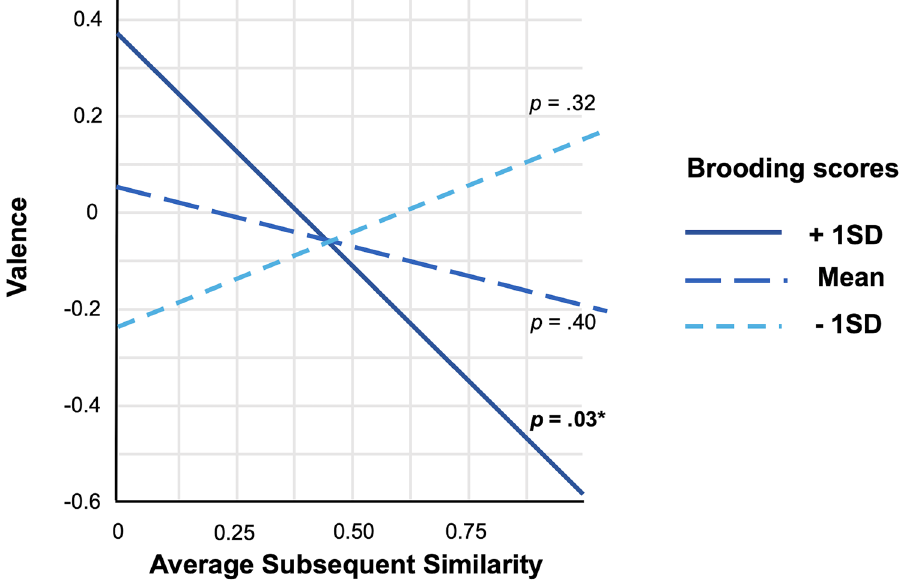
Figure 3. Brooding scores moderate the relationship between thought valence and average semantic similarity across subsequent thoughts. More negatively-valenced thoughts led to greater average subsequent semantic similarity (narrower conceptual scope) for individuals with higher brooding tendencies . The simple slopes relationships between valence and average subsequent semantic similarity for low and mean brooding groups was not significant. * P < .05.